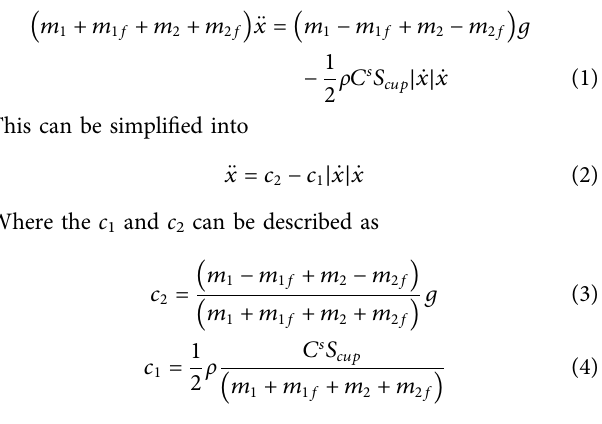
Frontiers in Energy Research |